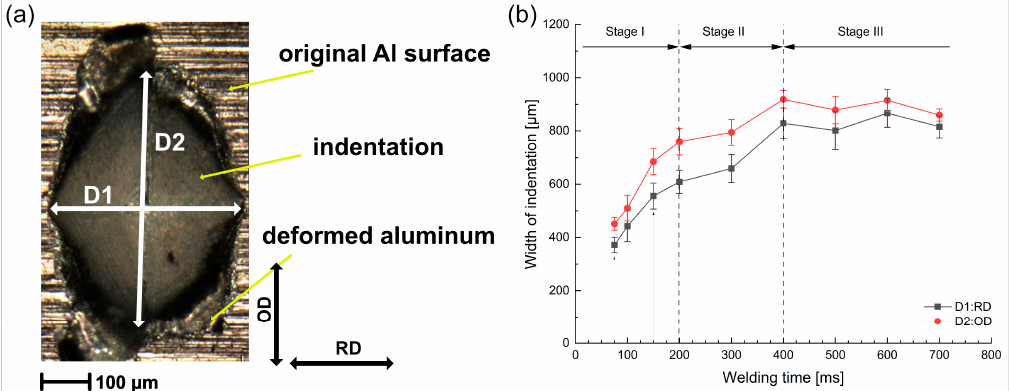
Figure 3. ( a ) Definition of widths for indentation D1 and D2. ( b ) Variation in widths of indentation D1 and D2 with welding time.